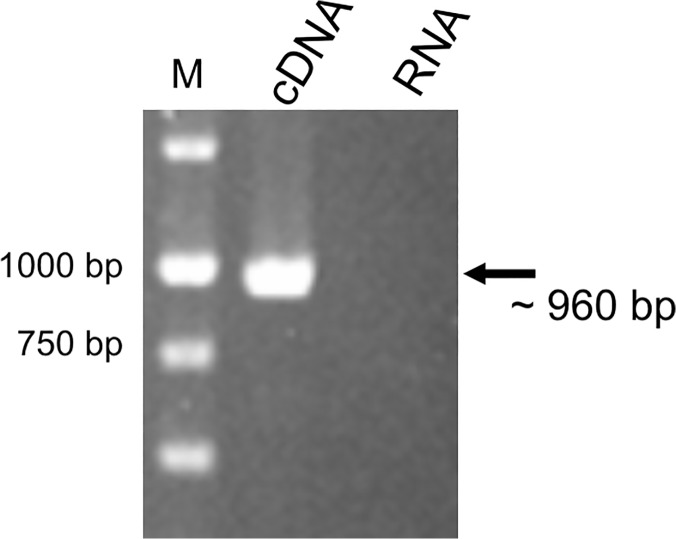
RT-PCR analysis of the acrRdsrE operon.The analysis was performed using total RNA isolated from strain Ye9 grown in LB medium at 27°C. The size of the amplified fragment was estimated by comparison with the size marker DNAs (lane M). A negative control reaction was performed using DNase-treated RNA as the template.